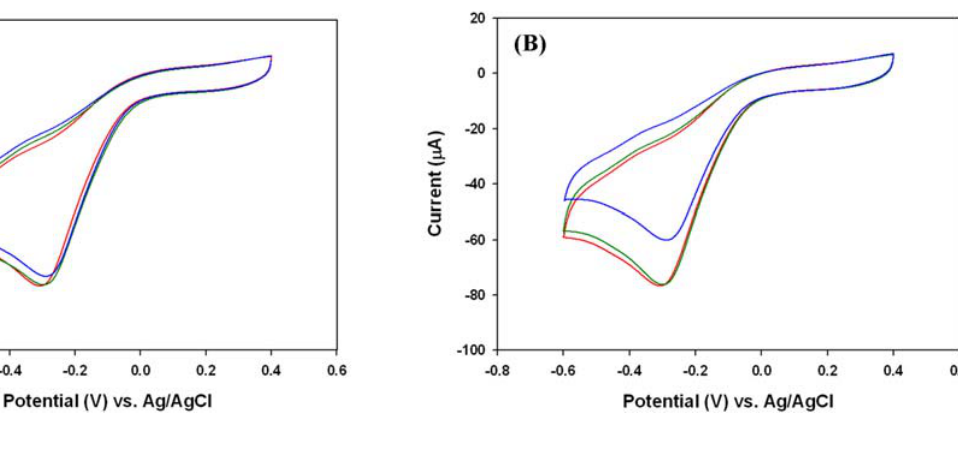
Figure 6. The effects of oxygen scavengers (A) sodium thiosulfate and (B) ascorbic acid on the detection of 2.39 mM H the concentrations of oxygen scavenger were 0 mM (red), 1 mM (green), and 5 mM (blue),